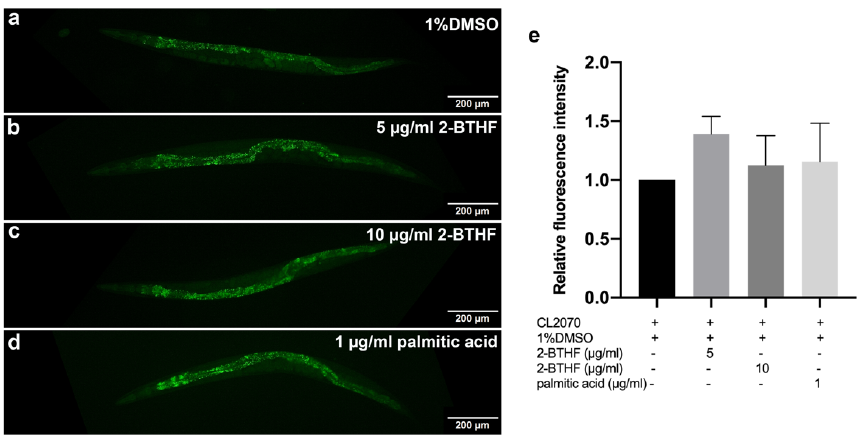
Figure 7. Effects of purified H. scabra compounds on HSP-16.2 expression in transgenic CL2070 strain. GFP expression of the worms treated with 1% DMSO (control) ( a ), 5 µ g/mL 2-BTHF ( b ), 10 µ g/mL 2-BTHF ( c ), and 1 µ g/mL palmitic acid ( d ) are shown. The relative fluorescence intensity of hsp-16.2:: GFP in the worm head region was quantified and shown ( e ). The results of HSP-16.2 GFP expression were analyzed by one-way ANOVA following Bonferroni’s